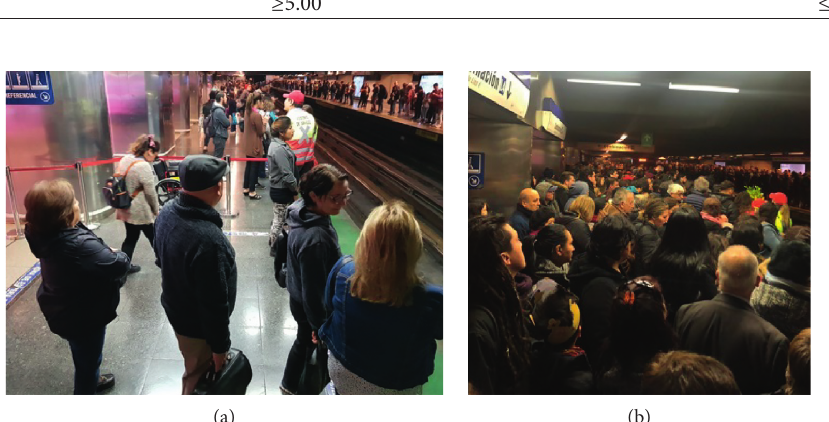
Figure 3: Densities observed in preferential waiting areas at the Tobalaba station in the Metro of